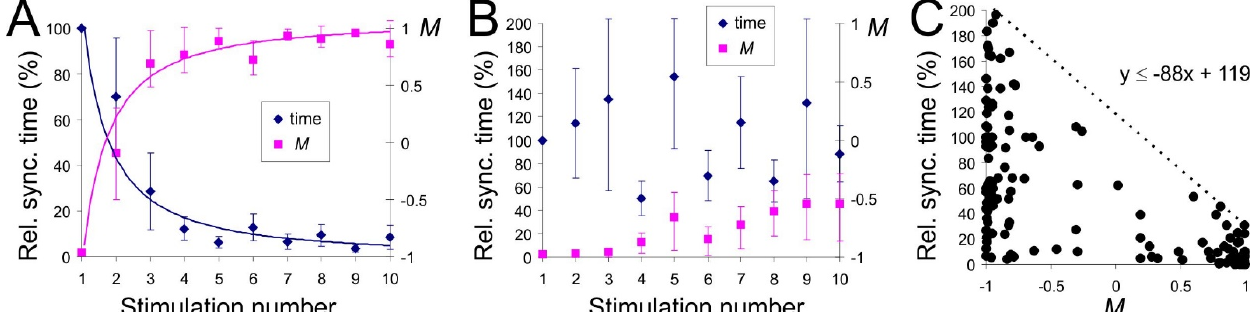
Figure 5. Correlation of the learning curve with the global network memory measure. ( A ) Averaged relative synchronization time (learning curve) and memory measure M as functions of the stimulus number. The time interval between successive stimulations is 10 (cid:2872) − 3 × 10 (cid:2872) s, the noise intensity D = 4.8 ( n = 10). The relative synchronization time is the time required to synchronize the network, normalized to the synchronization time at the first stimulation. M was evaluated just before the stimulation. ( B ) Same as in ( A ) but for the increased time interval between stimulations ( 5 × 10 (cid:2872) − 10 (cid:2873) s) and the intensity of neural noise ( D = 5.1-5.5; n = 10). ( C ) Synchronization time versus the global memory measure ( n = 200).